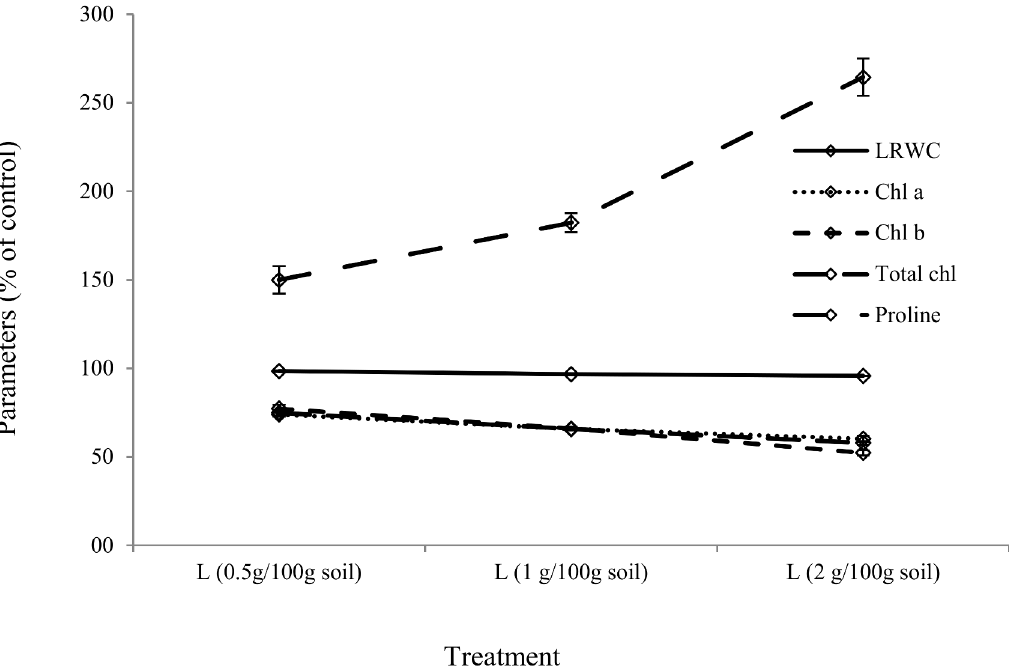
Fig 7. Effect of boneseed litter on biochemical parameters of X . bracteatum . The x-axis denotes the doses of litter (L) in g/100gm soil. The y-axis represents leaf relative water content (LRWC), chlorophyll a, chlorophyll b, total chlorophyll and proline content of X . bracteatum leaf. Data presented as % of control. The error bar indicates the standard